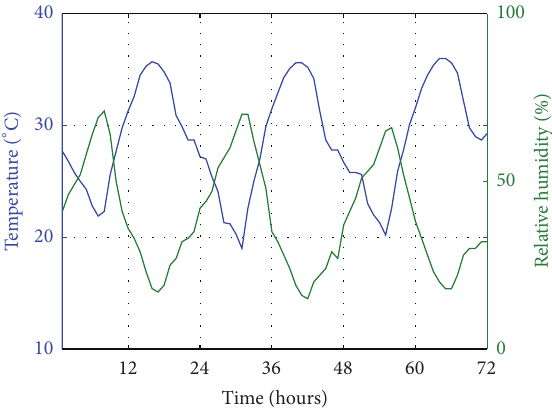
Figure 3: Temperature and air humidity measured in a meteorolog- ical station at Barra, Bahia, municipality in which the dunes region is located, for a period of 3 days in September 2008. Data obtained from INMET